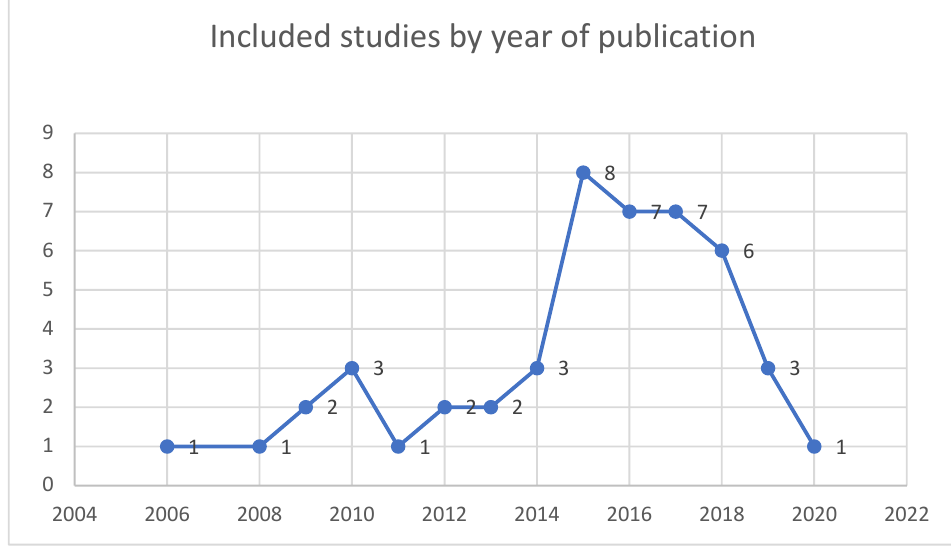
Figure 4. Included studies by year of Figure 5: Included countries mapped